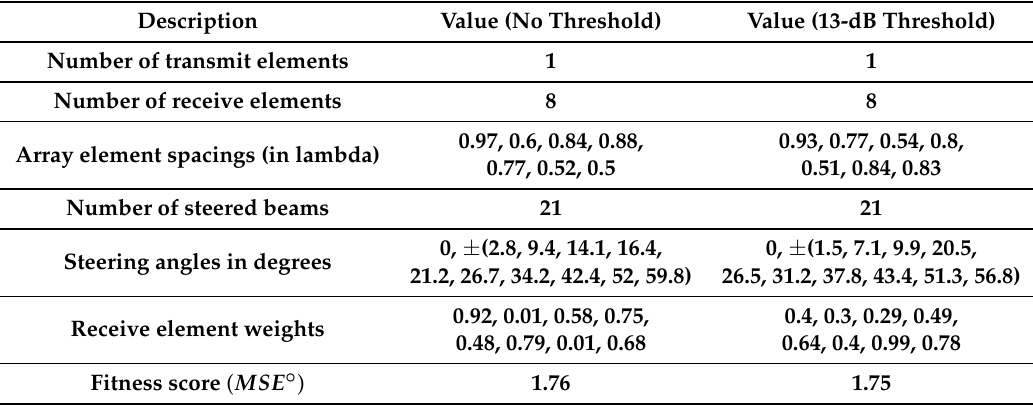
Table 10. Experiment 4 results.